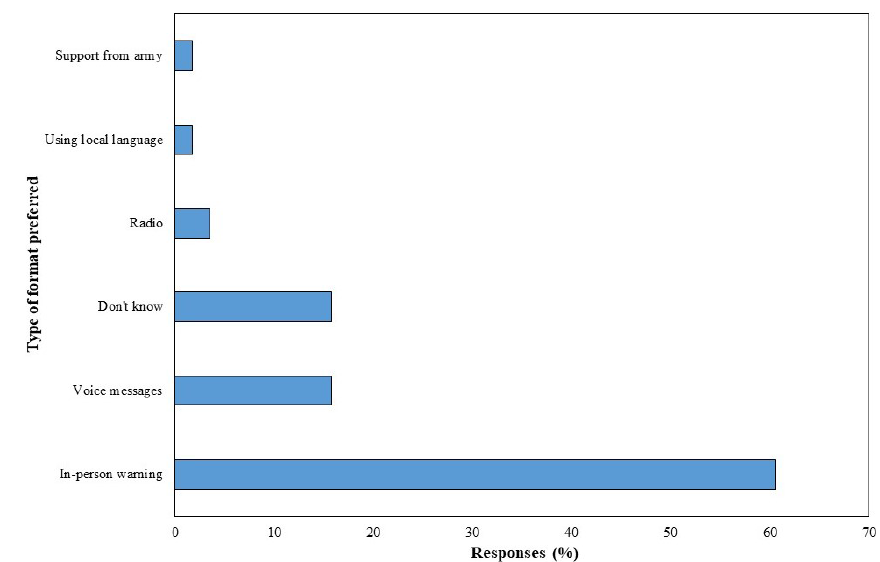
Figure 10. Preferred alternative method of communication suggested by community